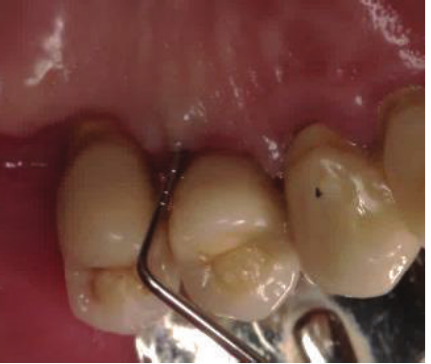
Figure 15: Two-year postoperative clinical examination revealed health hard and soft tissues with no bleeding and reduced probing depth (buccal and lingual/palatal probing shown).